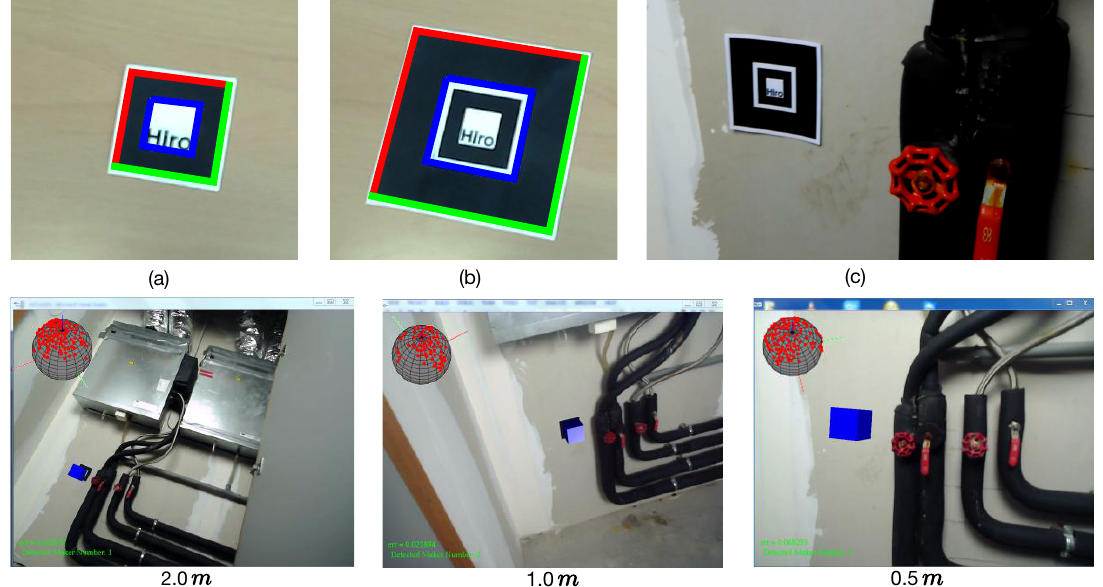
Figure 5. Camera pose training data collection using WatchPose.